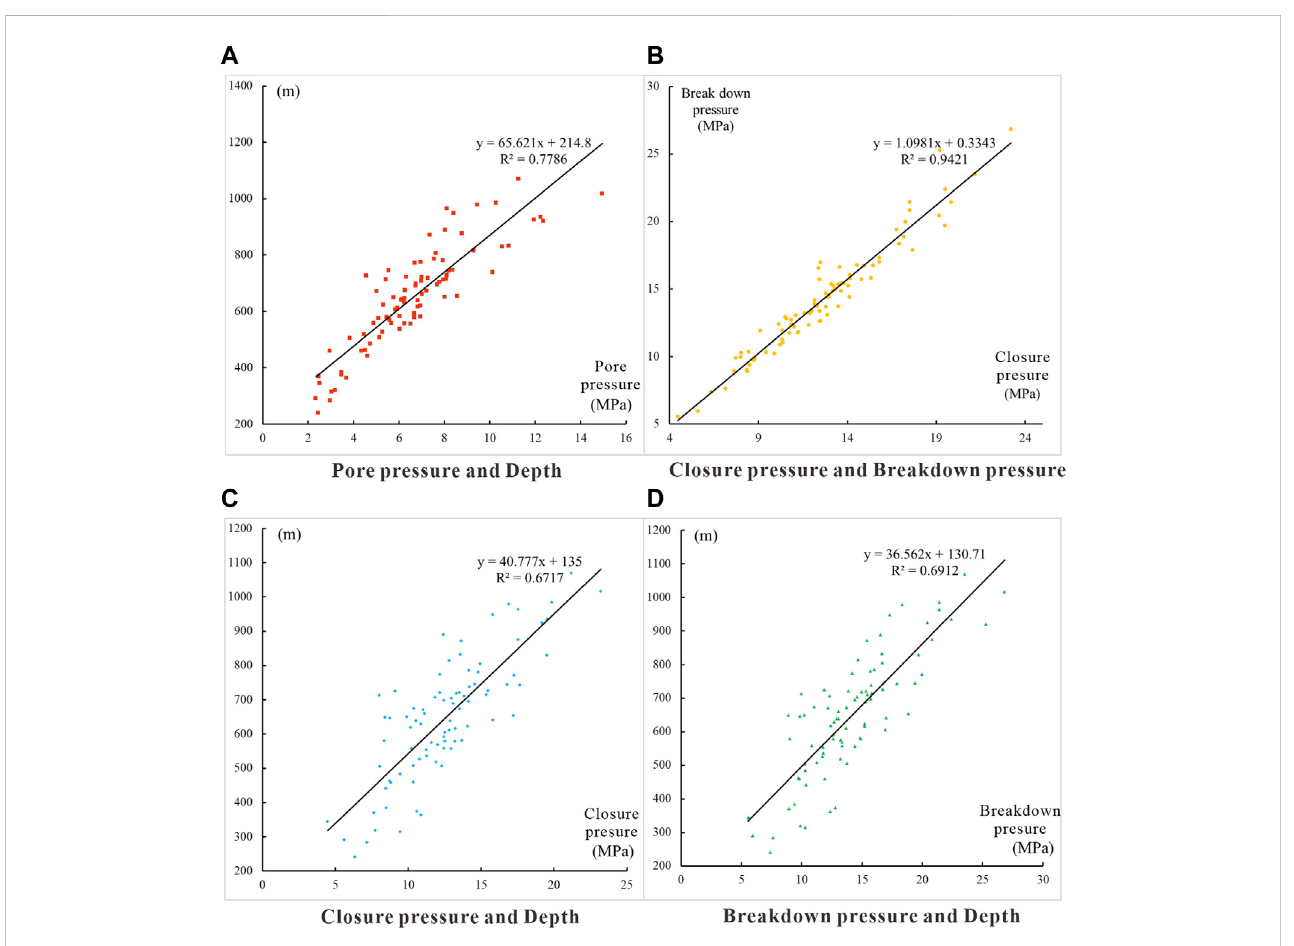
The relationship between pore pressure and depth (A) , closure pressure and breakdown pressure (B) , closure pressure and depth (C) , breakdown pressure and depth (D)